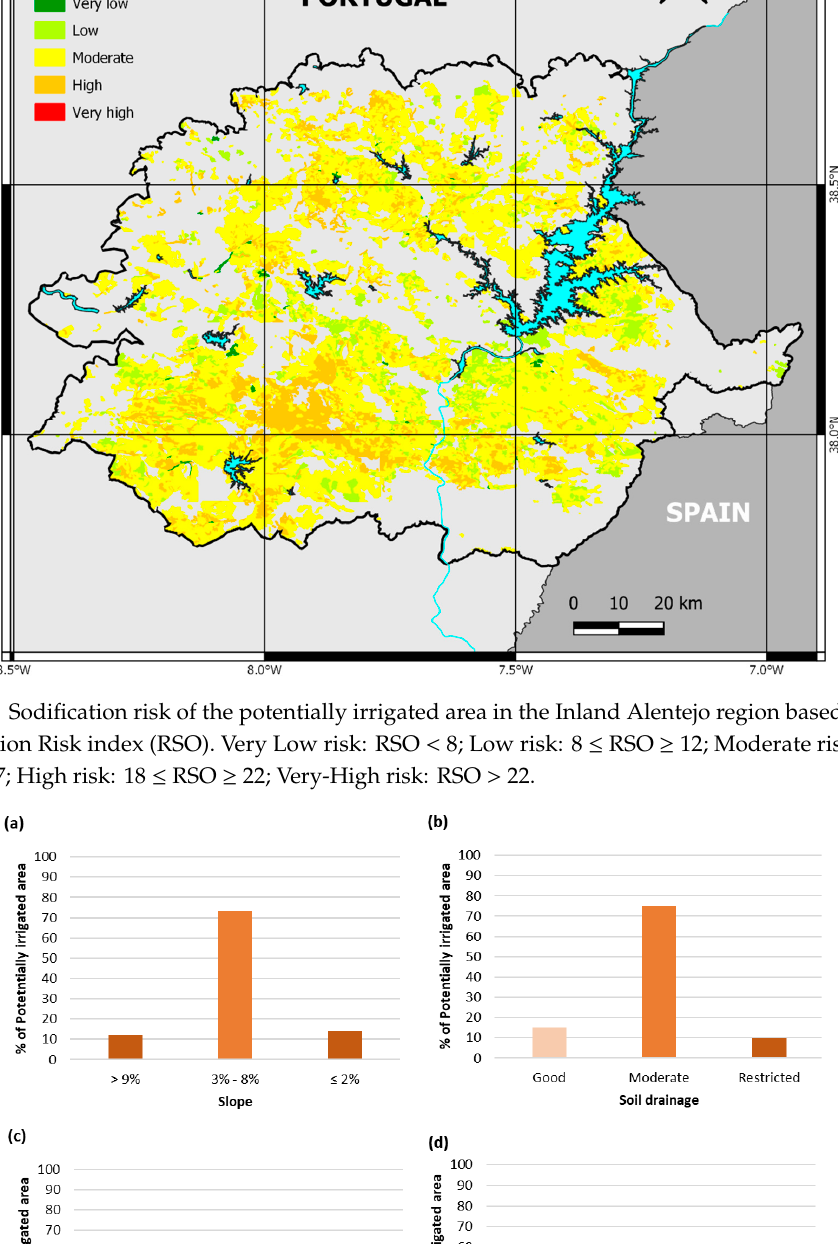
Figure 10. Percentages of Moderate Risk of Sodification areas per slope class ( a ), drainage class ( b ), soil reference group ( c ), land occupation ( d ) and irrigation method ( e ). LP—Leptosols; LV—Luvisols; VR—Vertisols; CL—Calcisols; RG—Regosols; CM—Cambisols. OL—Olive groves; FT—Fruit trees; VN—Vineyards; TC—Temporary crops; TP—Temporary crops and/or improved pastures; CP— Complex crop patterns. The analysis of the relationships between the RSO index and its indicators in high-risk areas showed a strong prevalence of flat and low slope terrain (Figure 11a), moderate-to-restricted soil drainage in Luvisols, Vertisols and Cambisols (Figure 11b,c), and annual crops irrigated with surface or sprinkler systems (Figure 11d,e). The results were in accordance with Sentís [36], who, in their study to evaluate the development of secondary sodicity in the surface soil, found that it was strongly affected by inadequate drainage and inefficient irrigation. This risk prediction could indicate that even non-sodic soils with ESP (or SAR) < 3 can have a tendency for swelling, aggregate failure, and increase in dispersion rates, thus behaving like sodic soils at very low electrolyte concentration [82]. As a consequence, soil infiltration rates decline and surface crust formation problems can occur, conditions that may worsen due to the physical disruption of soils particles caused by the use of sprinkler irrigation systems. Although clay soils are more affected by sodicity, it should be considered that there are some soil properties, other than texture, that are significant in influencing the behavior of soils under sodification risk, namely, depth and thickness of the sodic horizons and clay mineralogy. For instance, the presence of high-activity clay minerals, like smectite, is likely to increase the soil susceptibility to sodification [83].